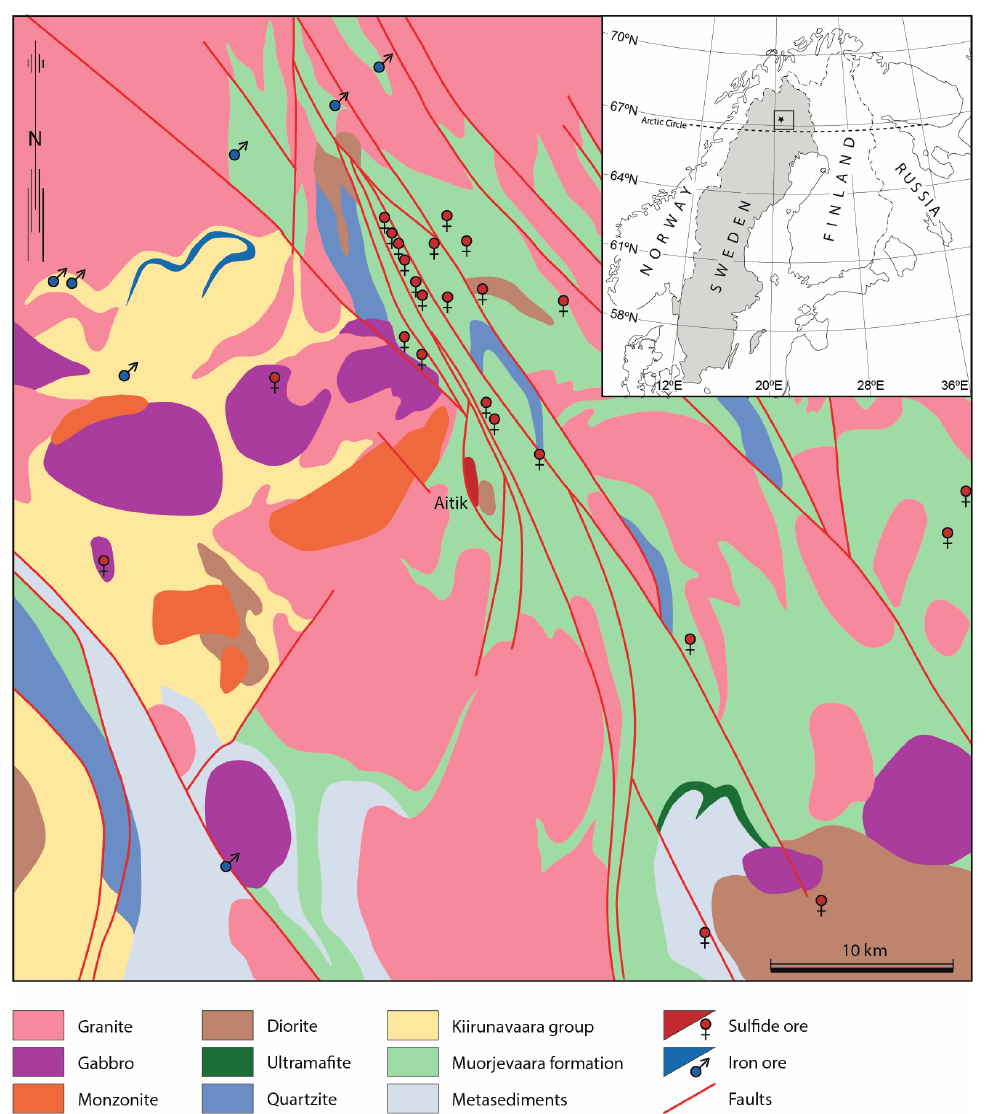
Figure 1. Geology of the Gällivare area (modified from [2]). Inset shows the location of the Gällivare area (rectangle) and the Aitik deposit (star) within the Fennoscandian